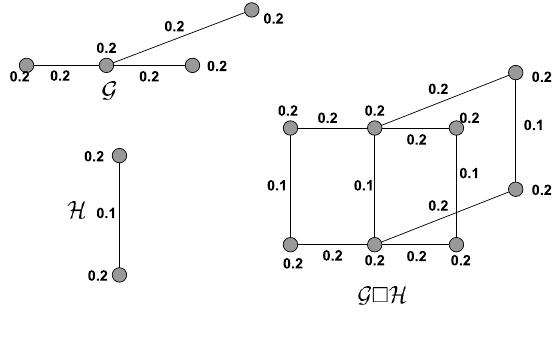
Figure 6: Fuzzy graph G , H and G (cid:50)